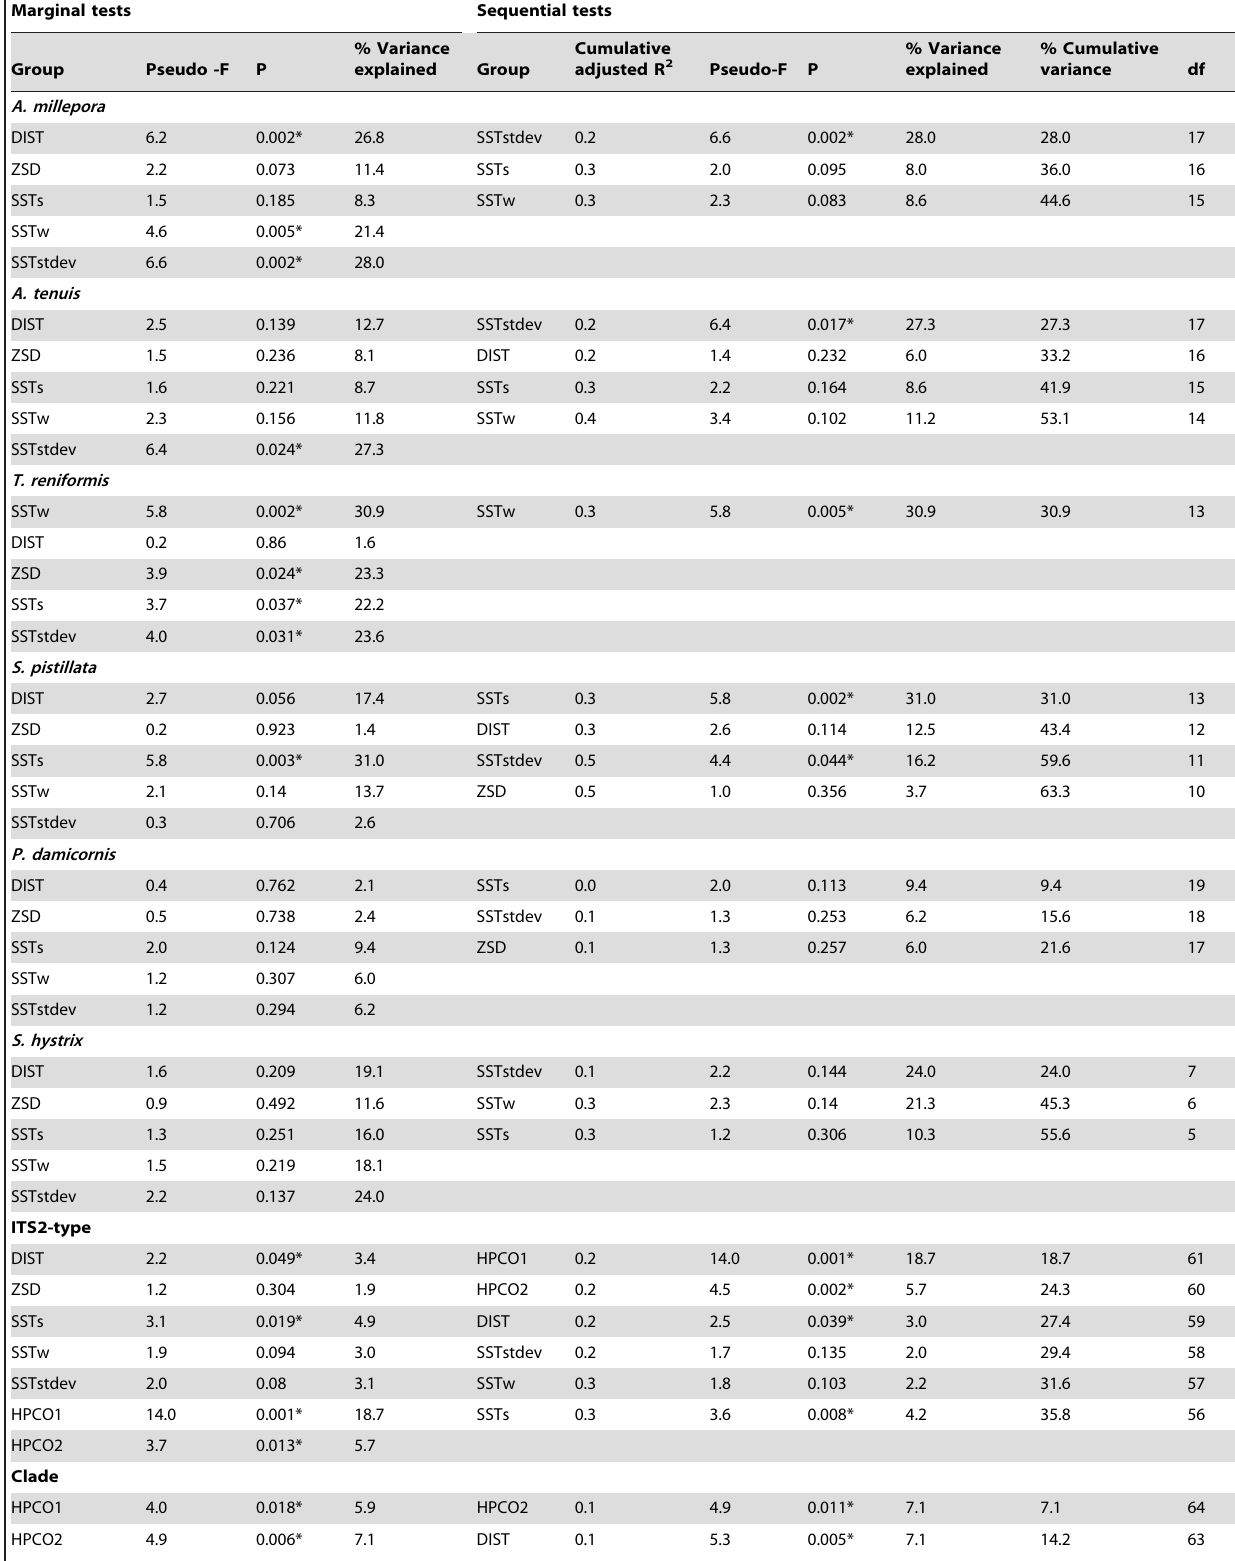
Table 1. Summary of distLM